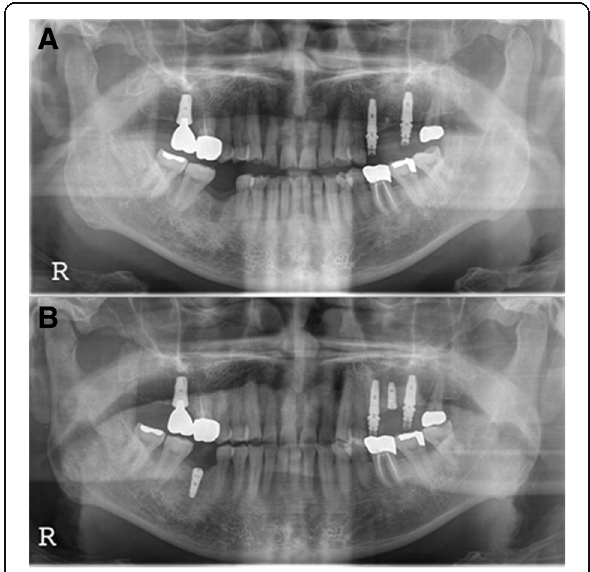
Fig. 3 M3, panoramic radiograph, a postoperative 1-month removal of fixture state, b #46i, second